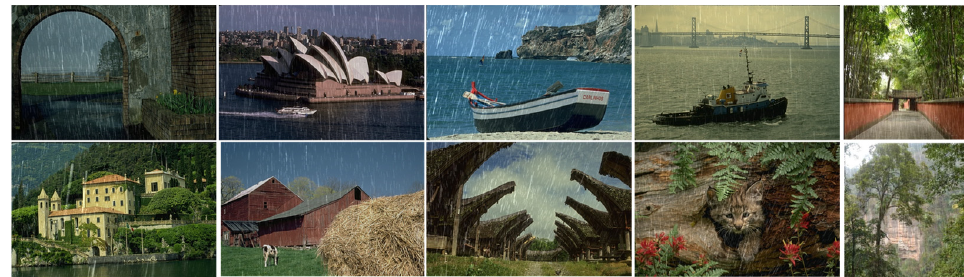
Figure 2. Ten test images in our experiments.